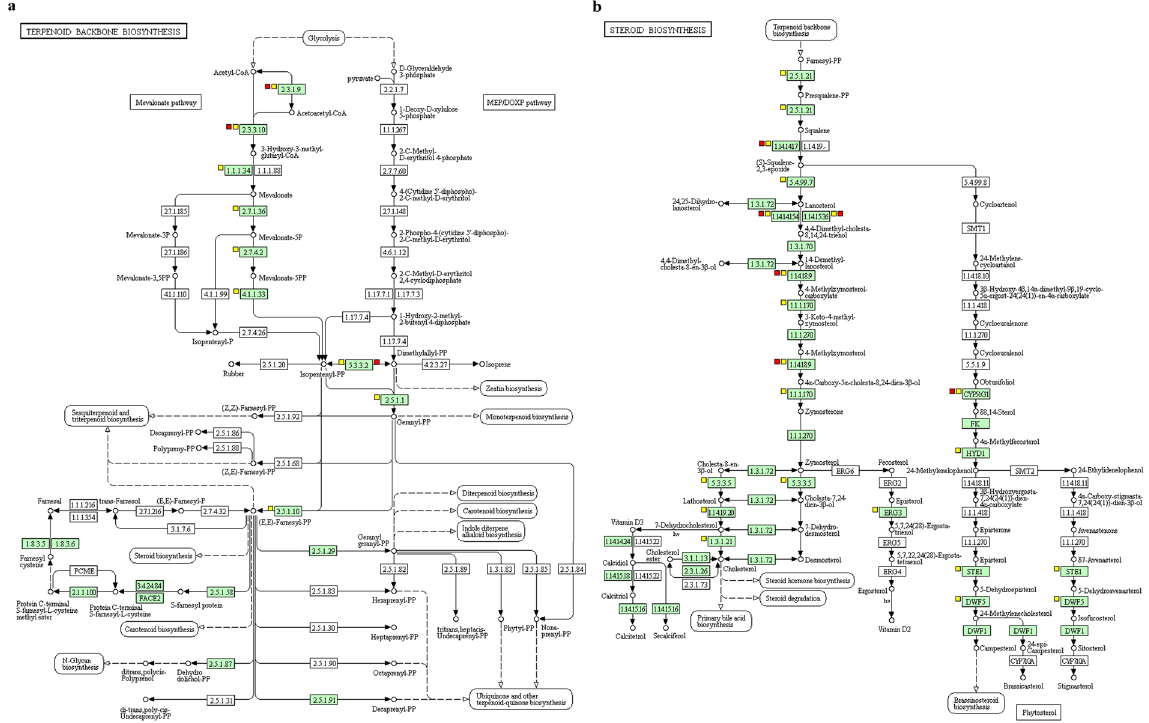
Figure 3. KEGG pathways involved in the lipid methabolism of zebrafish enriched after MPs exposure. ( a ) Terpenoid backbone biosynthesis (L-MPs FDR = 2.40E-07; H-MPs FDR = 0.191679). ( b ) Steroid biosynthesis (L-MPs FDR = 1.11E-08; H-MPs FDR = 0.228282). Green boxes represent genes involved in the organism- specific pathway for Danio rerio . Yellow squares next to the pathway steps indicate genes that are down- regulated transcribed after L-MPs exposure (100 µ g/L). Red squares next to the pathway steps indicate genes that are down-regulated transcribed after H-MPs exposure (1000 µ g/L). Pathway images obtained from KEGG 50,51 .